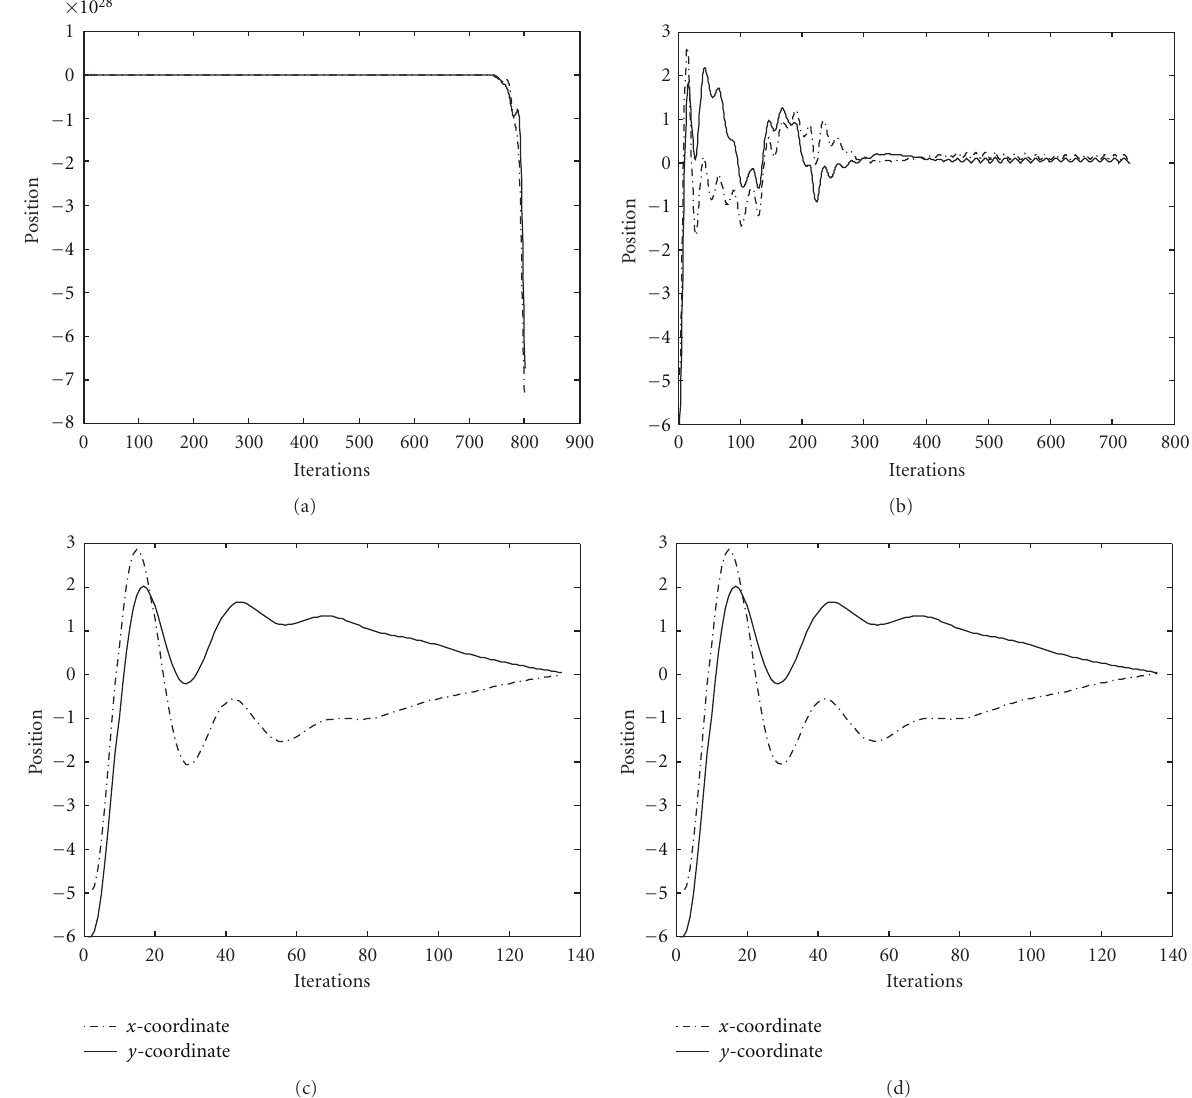
Figure 3: (a) Position coordinates using the EKF and a low inflation rate. (b) Position coordinates using the EKF and a high inflation rate. (c) Position coordinates using the NEKF and a low inflation rate. (d) Position coordinates using the NEKF and a higher inflation rate that is allowed to decay after 80 iterations.